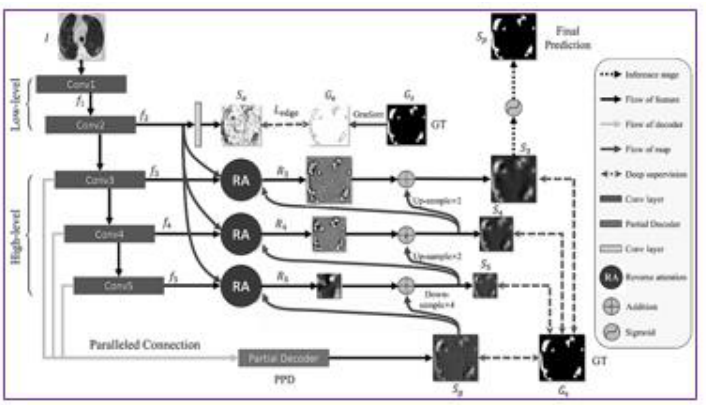
Figure 4. PInfection net (InfNet) architecture specialized for disease detection [28].